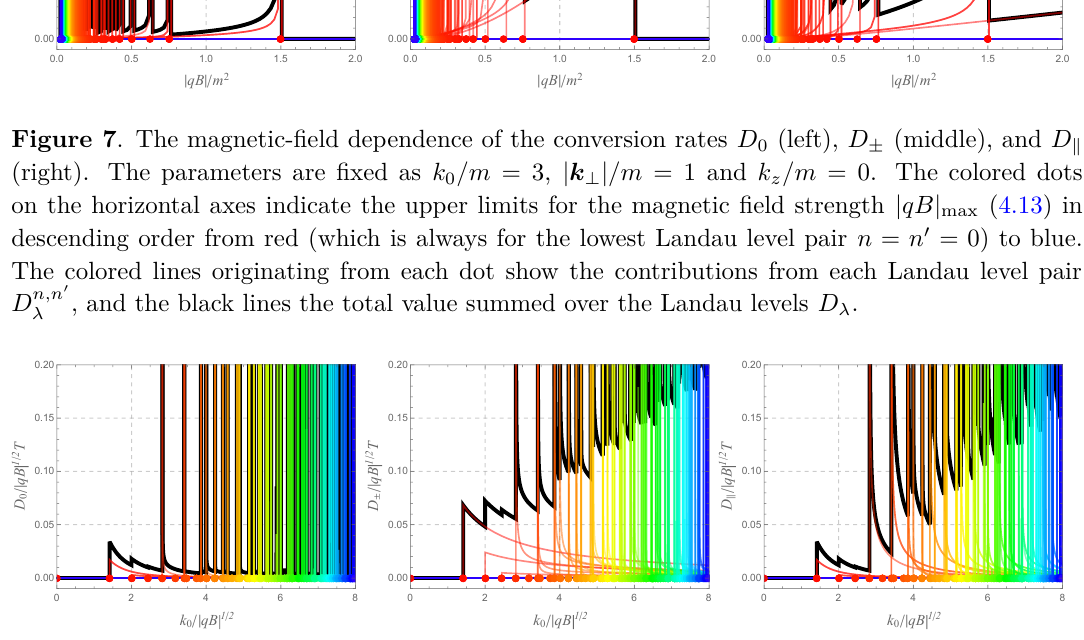
(right) in the massless limit m = 0 , Figure 8 . The conversion rates D 0 (left), D ± (middle), and D k plotted against the photon energy k 1 / 2 . The other parameters are fixed at | k 1 / 2 = 1 0 / | qB | ⊥ | / | qB | and k 1 / 2 = 0 . As in figure 4, the colored dots on the horizontal axes indicate the threshold z / | qB | energies (4.4) in ascending order from red to blue. The colored lines originating from each dot show the contributions from each Landau level pair D n,n 0 , and the black lines the total value summed λ over the Landau levels D λ